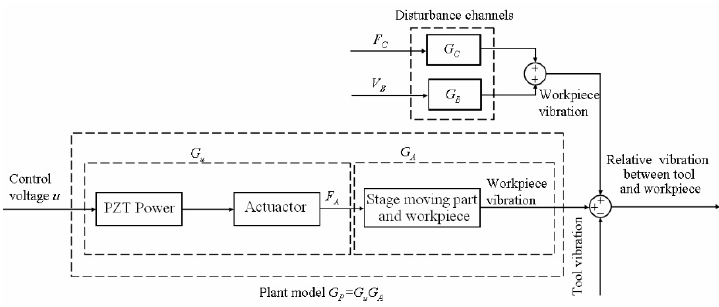
Fig. 3. Block diagram of